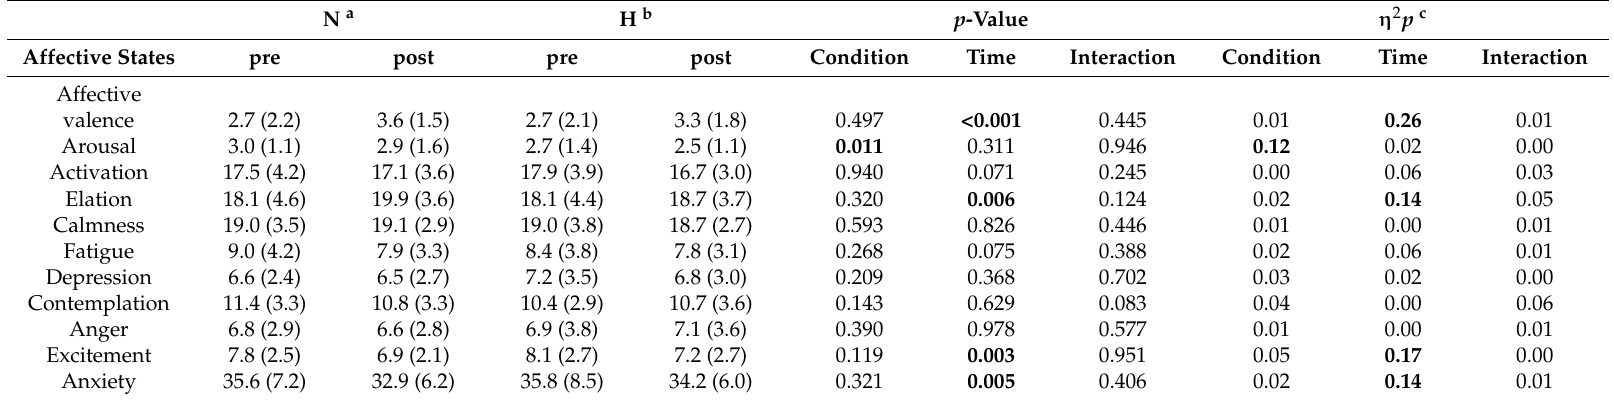
Table 2. Mean (SD) values for affective states by condition and time